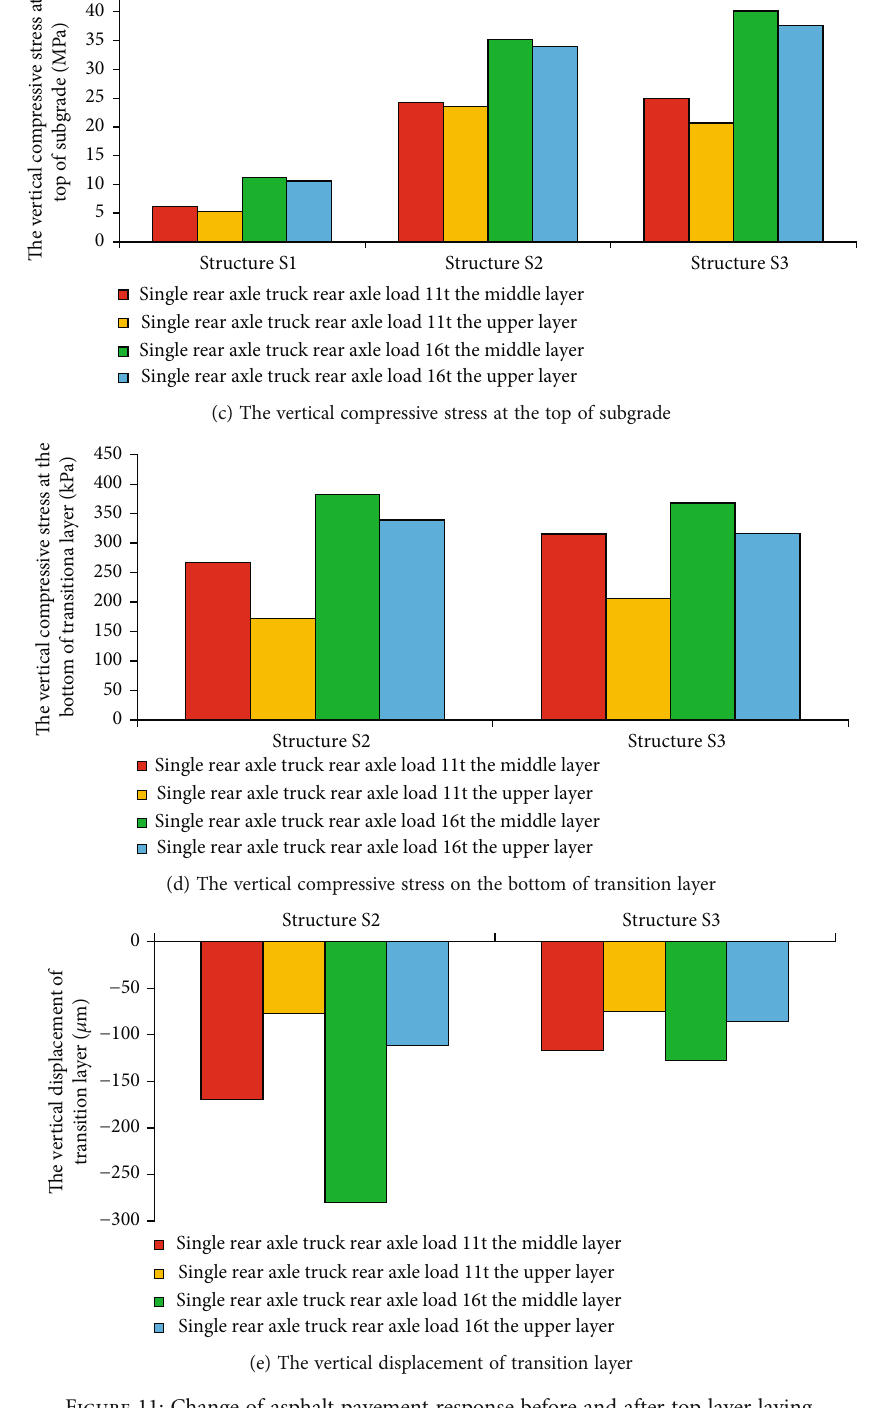
(e) The vertical displacement of transition layer Figure 11: Change of asphalt pavement response before and after top layer